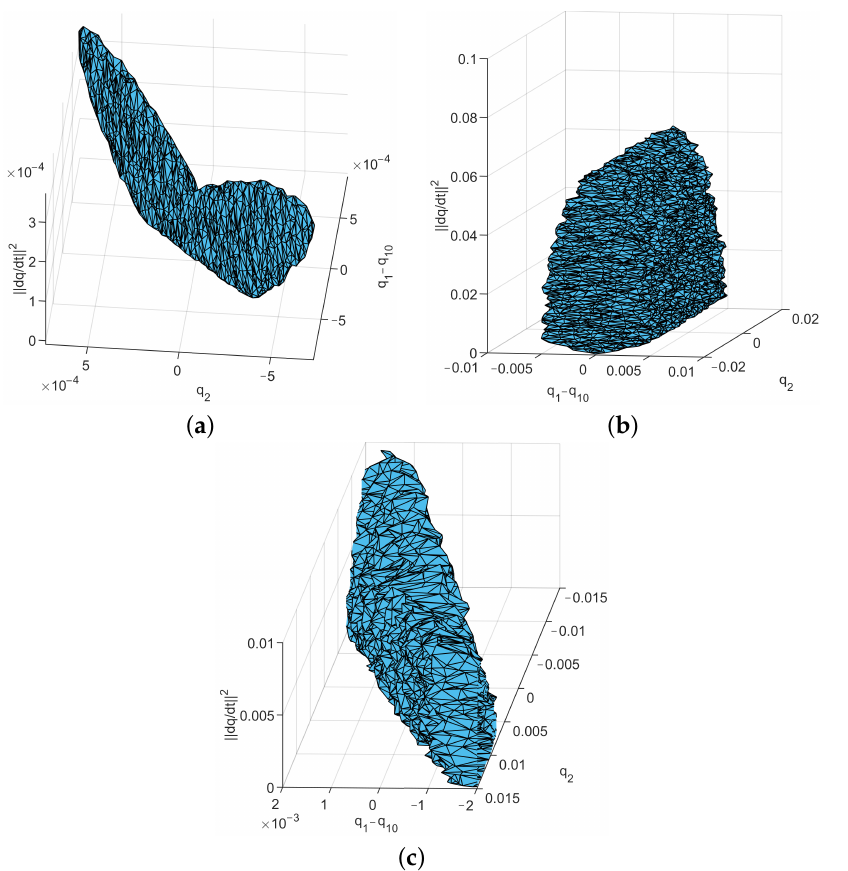
Figure 3. Area of convergence estimated in a conservative way based on the Lyapunov analysis: